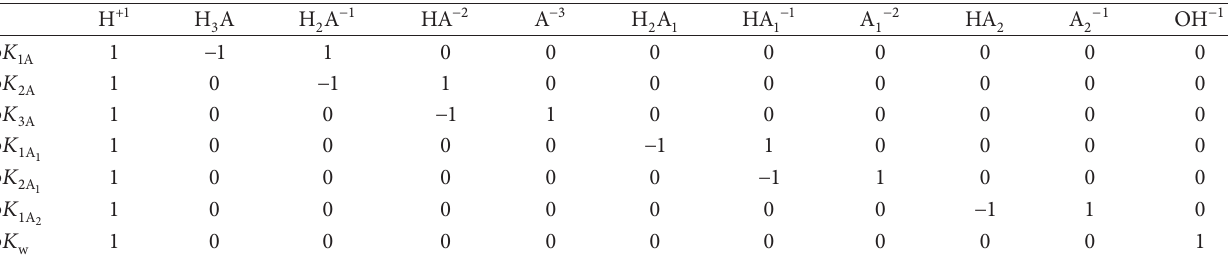
Table 2: Stoichiometric matrix for model 2.